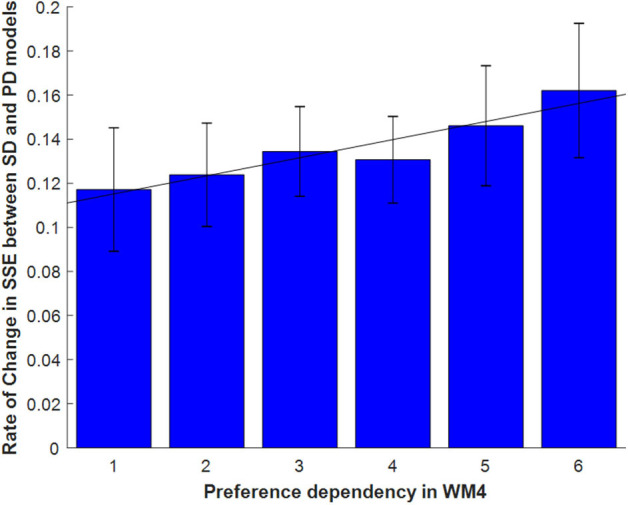
SSE changes from the SD to the PD model in six groups with different degrees of preference dependency in the working-memory task. For x-axis, preference dependency in the working-memory task was measured (see main text), and participants were divided into six groups based on their relative preference dependency from low to high. The y-axis then measures the extent to which the PD model captures this preference dependency, using | [(SSE of PD model) - (SSE of SD model)]/(SSE of SD model) |. Participants whose working-memory performance reflected a low degree of preference dependence (Group 1) showed little performance difference between the PD and SD models, while participants whose working-memory performance reflected a high degree of preference dependence (Group 6) required the PD rather than the SD model to describe their remembered utility. The group index (1–6) was strongly correlated with the improvement from the SD to PD models (r = 0.9478, p = 0.0040), as illustrated by the fitting line. The result shows that the additional degree of freedom of the PD model was necessary to capture preference-dependent working-memory effects.